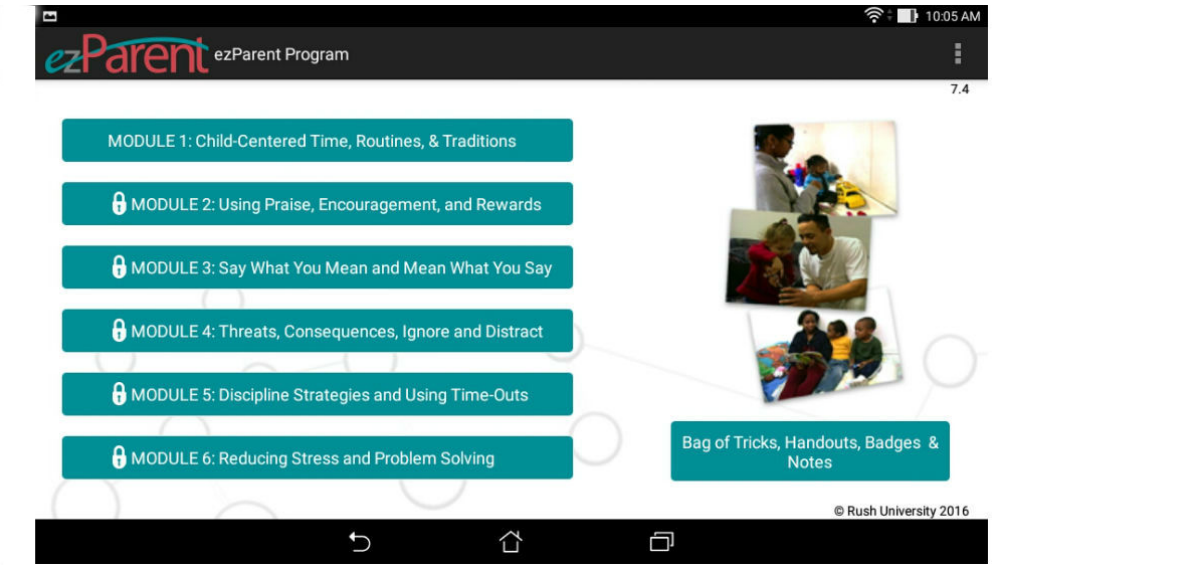
Figure 1. ezPARENT program home page and module